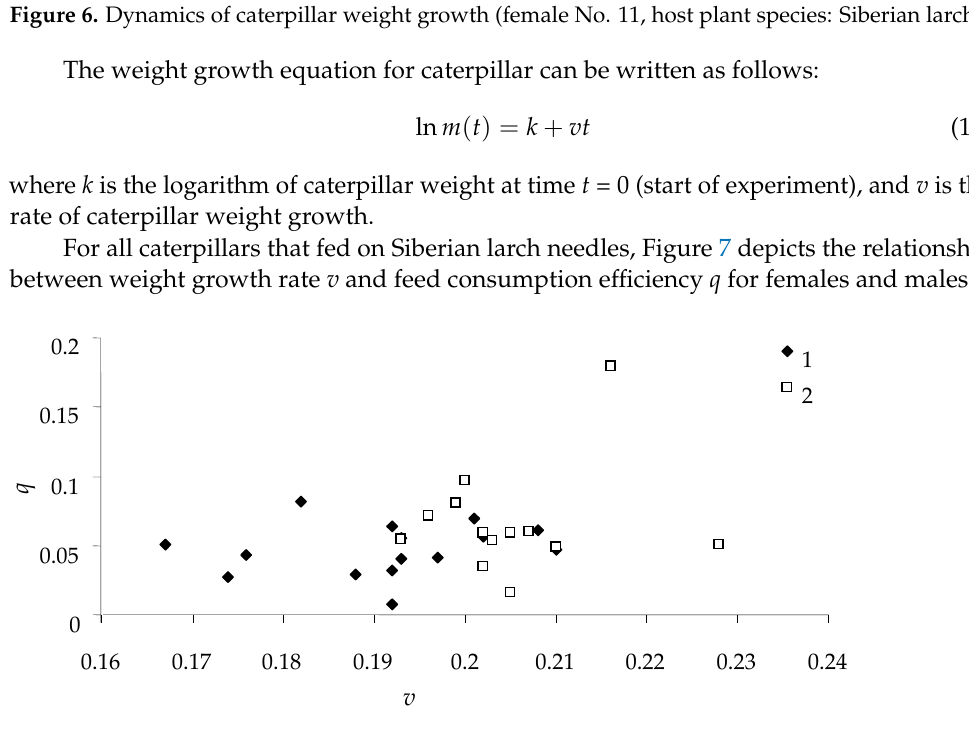
Figure 8. The relationship between caterpillar feeding efficiency q and caterpillar fecundity F (weight of laid eggs) for insects reared on all types of feed. Host plant species: (1) pine; (2) larch; (3) birch; (4) regression line for caterpillars feeding on all the host species. As displayed in Figure 8, the relationship between feeding efficiency q and fecundity F was significant, and the coefficient of determination R 2 for the correlation between q and F was 0.60. The responsiveness 306.1 =  qm